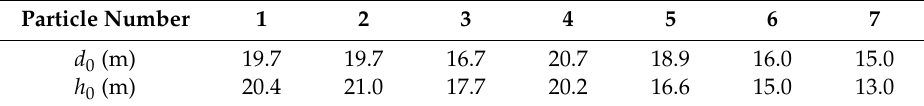
Figure 1. SEM micrographs showing ( a ) the morphology and ( b , c ) the cross-section of the particles of the examined Inconel 718 powder. Table 1. Measured particle dimensions.